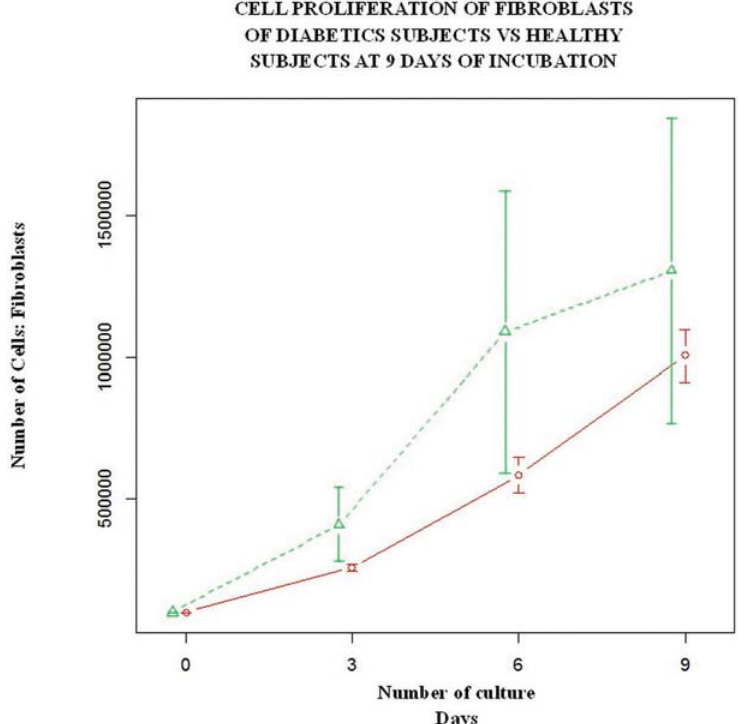
Figure 3- (cid:3)(cid:38)(cid:72)(cid:79)(cid:79)(cid:3)(cid:74)(cid:85)(cid:82)(cid:90)(cid:87)(cid:75)(cid:3)(cid:70)(cid:88)(cid:85)(cid:89)(cid:72)(cid:17)(cid:3)(cid:38)(cid:72)(cid:79)(cid:79)(cid:3)(cid:83)(cid:85)(cid:82)(cid:79)(cid:76)(cid:73)(cid:72)(cid:85)(cid:68)(cid:87)(cid:76)(cid:82)(cid:81)(cid:3)(cid:82)(cid:73)(cid:3)(cid:87)(cid:75)(cid:72)(cid:3)(cid:191)(cid:69)(cid:85)(cid:82)(cid:69)(cid:79)(cid:68)(cid:86)(cid:87)(cid:86)(cid:3)(cid:82)(cid:73)(cid:3)(cid:71)(cid:76)(cid:68)(cid:69)(cid:72)(cid:87)(cid:76)(cid:70)(cid:86)(cid:3)(cid:86)(cid:88)(cid:69)(cid:77)(cid:72)(cid:70)(cid:87)(cid:86)(cid:3)(cid:89)(cid:86)(cid:3)(cid:75)(cid:72)(cid:68)(cid:79)(cid:87)(cid:75)(cid:92)(cid:3)(cid:86)(cid:88)(cid:69)(cid:77)(cid:72)(cid:70)(cid:87)(cid:86)(cid:3)(cid:68)(cid:73)(cid:87)(cid:72)(cid:85)(cid:3)(cid:28)(cid:3)(cid:71)(cid:68)(cid:92)(cid:86)(cid:3)(cid:82)(cid:73)(cid:3)(cid:76)(cid:81)(cid:70)(cid:88)(cid:69)(cid:68)(cid:87)(cid:76)(cid:82)(cid:81)(cid:17)(cid:3)(cid:39)(cid:76)(cid:68)(cid:69)(cid:72)(cid:87)(cid:76)(cid:70)(cid:3) subjects (green) had an increased cell proliferation since day 3 in comparison with healthy subjects Table 2- Cell proliferation at the growth cell curve